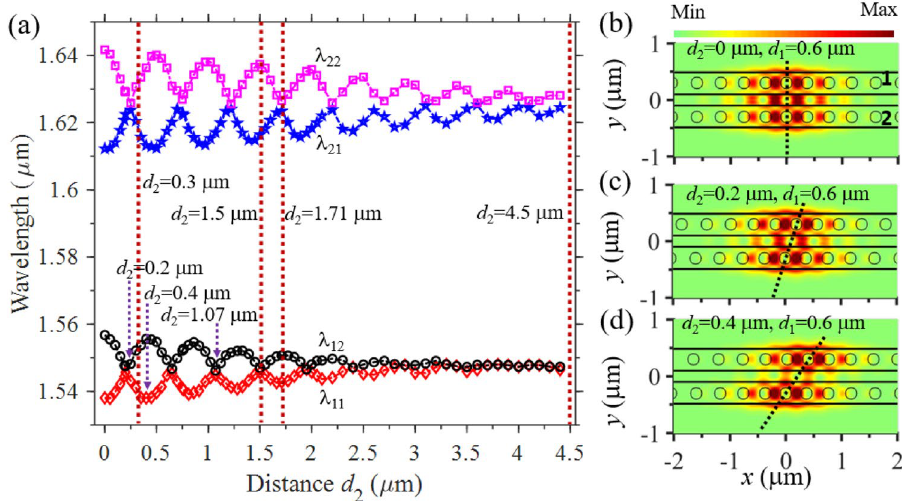
Figure 3. Influence of the axial shift d 2 to the wavelength splitting of the resonance modes of the double coupled-nanobeams (see Fig. 1a). ( a ) The dependence of the four splitting wavelengths (i.e., (cid:31) 11 , (cid:31) 12 , (cid:31) 21 and (cid:31) 22 ) on d 2 , which indicates quasi-periodic change of the coupling strength of the resonance modes and hence allows us to selectively generate TESs by the finite SSH nanobeams. ( b – d ) Zoom of the electric field distribution | E | in the middle plane of the nanobeam membrane (see the field distribution H z in Fig. S3 in Supplementary Information) at the splitting wavelengths of (cid:31) 11 = 1.538 µ m when d 2 = 0 µ m , (cid:31) 11 = 1.546 µ m when d 2 = 0.2 µ m , and (cid:31) 11 = 1.538 µ m when d 2 = 0.4 µ m , respectively, where the black dotted lines link the central holes of the two nanobeams. The transverse spacing in above simulations is fixed at d 1 = 0.6 µ m and the other geometrical parameters are the same as those in Fig. 1.